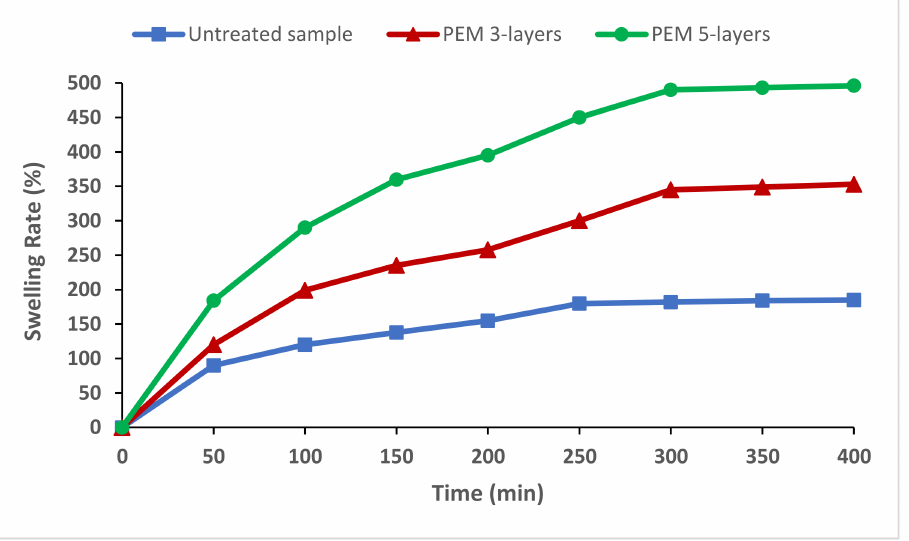
Figure 4. Swelling performance of untreated and functionalized PEM cellulosic bio-sorbents with different